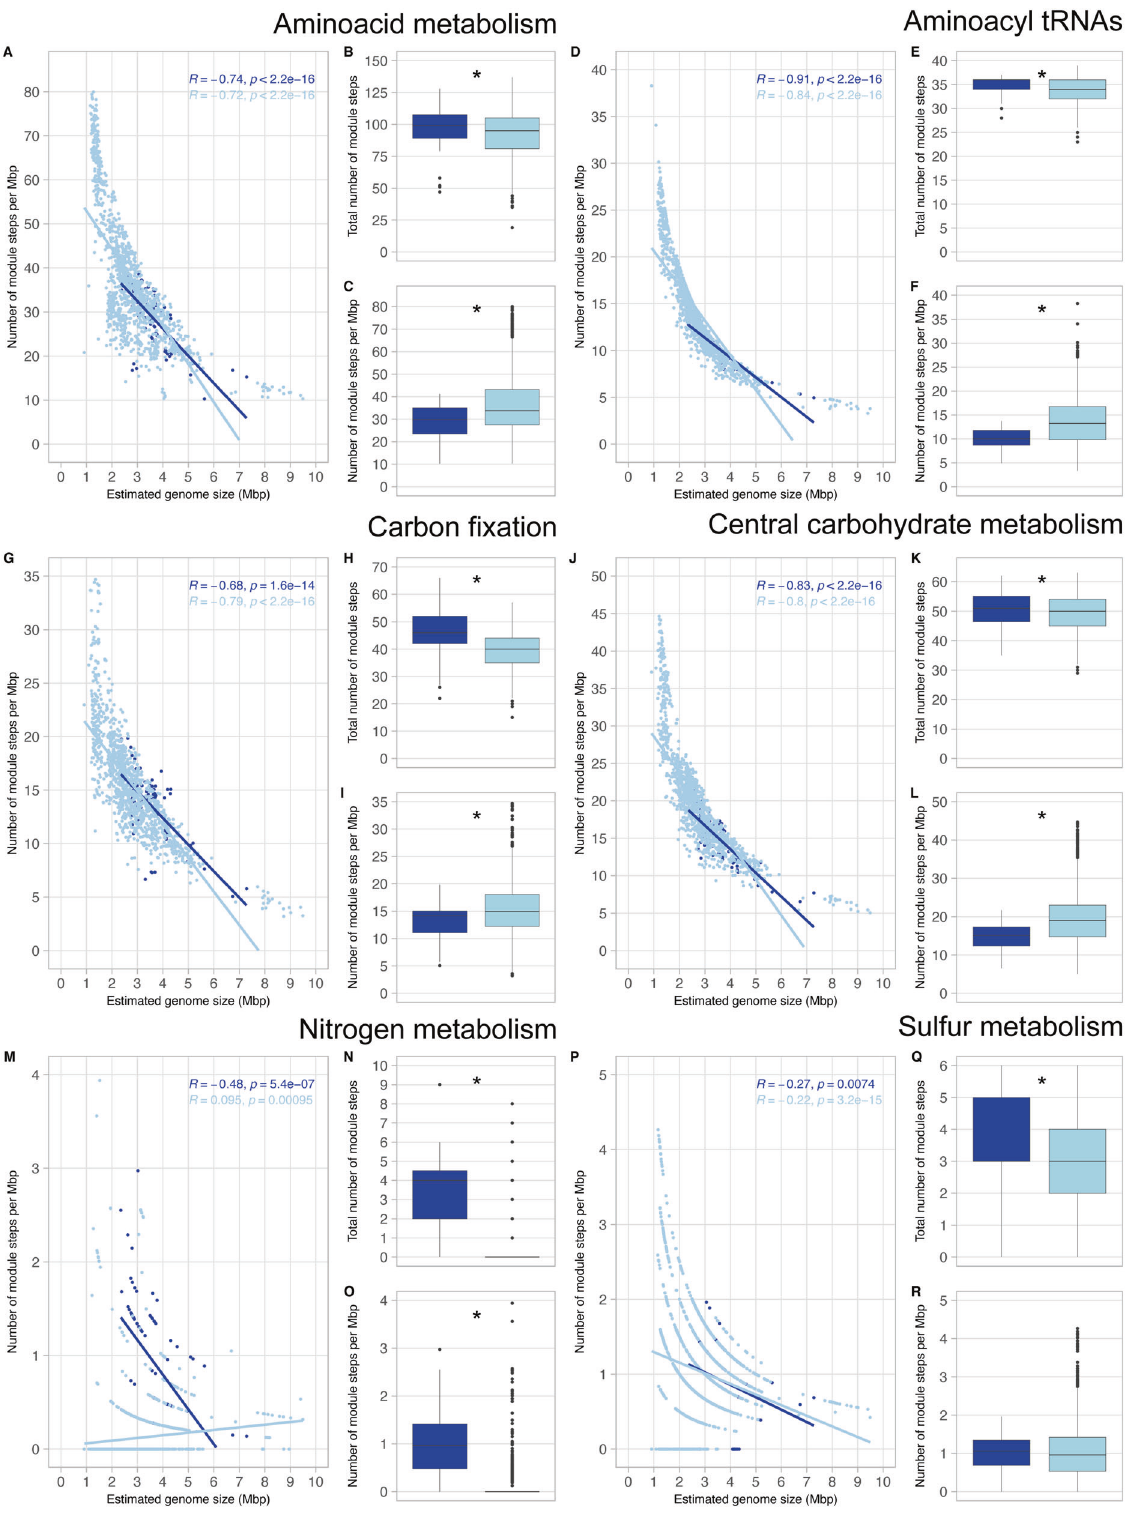
Fig. 5 Overview of the presence of module steps for six metabolic categories. The analyzed metabolic capabilities include amino acid metabolism ( A – C ), aminoacyl tRNAs ( D – F ), carbon fi xation ( G – I ), central carbohydrate metabolism ( J – L ), nitrogen metabolism ( M – O ) and sulfur metabolism ( P – R ). We used all bacterial MAGs with very-high quality (>90% completeness and <5% contamination), from both environments (99 MAGs from sediments and 1215 MAGs from water column). Stars in boxplots indicate signi fi cant differences p < 0.05 (Wilcoxon non- parametric test). B , E , H , K , N and Q indicate total number of module steps. C , F , I , L , O and R indicate the number of module steps per